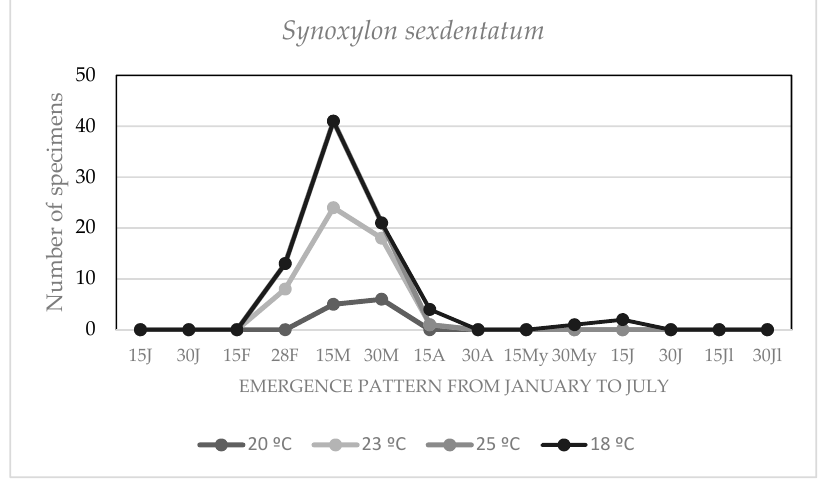
Figure 3. Emergence pattern of Synoxylon sexdentatum at different temperatures “°C” from January to July.